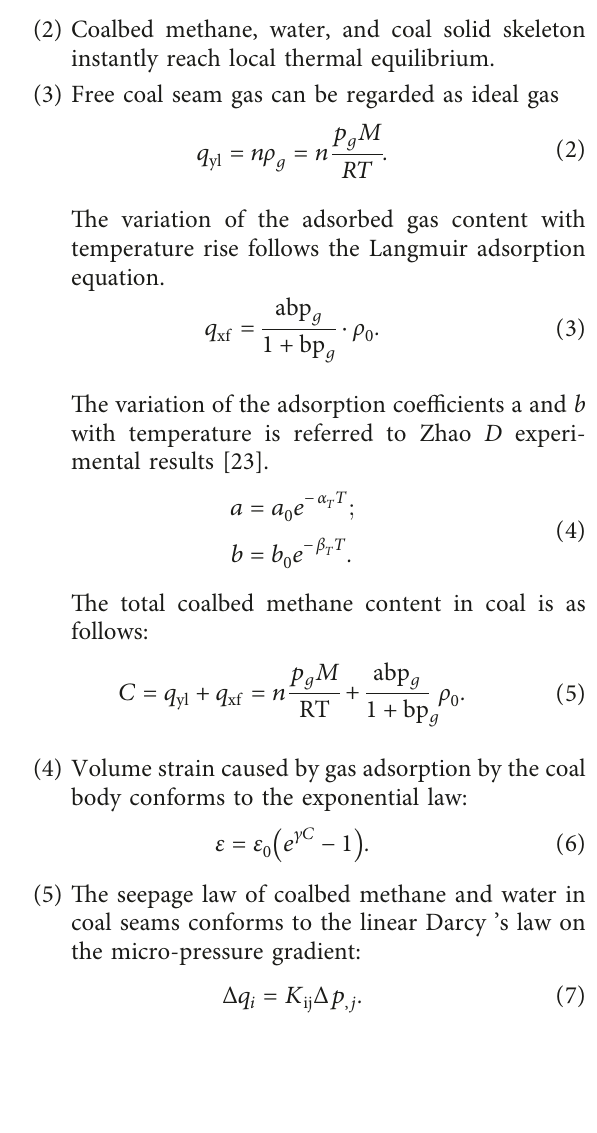
Figure 3: Relationship between volumetric deformation and methane content of different coal samples. (a) Guandi coal sample, (b) Tunlan coal